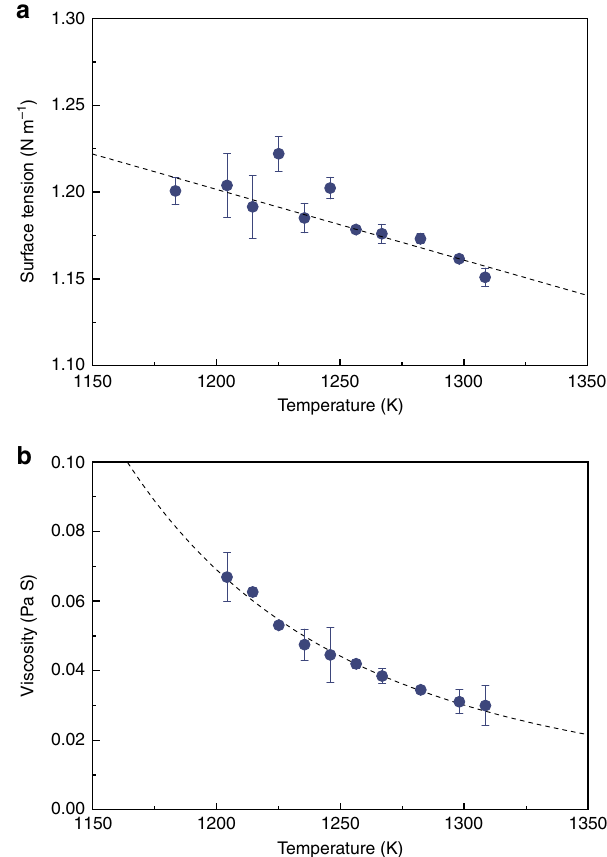
Fig. 1 Thermophysical properties of the bulk-metallic glass. a Surface tension ( γ ) and b viscosity ( η ) of the Zr 46 Cu 30.14 Ag 8.36 Al 8 Be 7.5 BMG- forming alloy melt measured by electrostatic levitation (ESL) over the temperature range from 1180 to 1310 K. The surface tension decreases by a mere 5% over the temperature range, while the viscosity for the melt decreases by ~50% with increasing